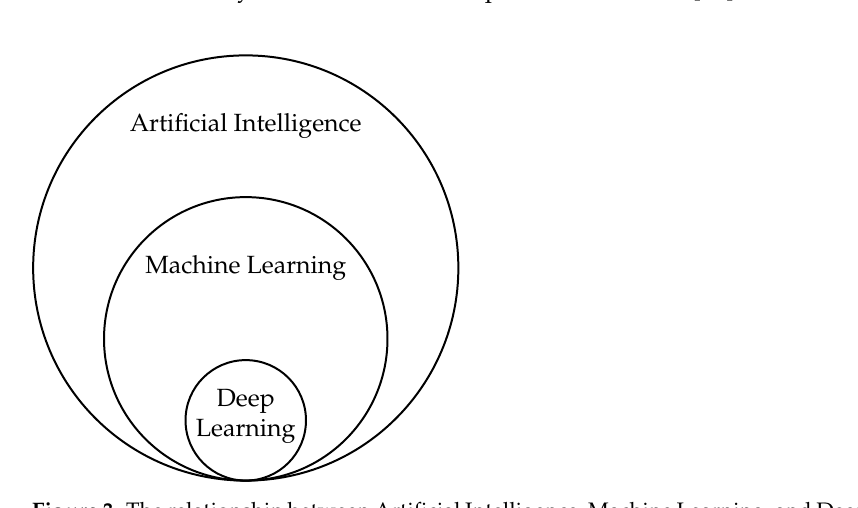
Figure 3. The relationship between Artificial Intelligence, Machine Learning, and Deep Learning